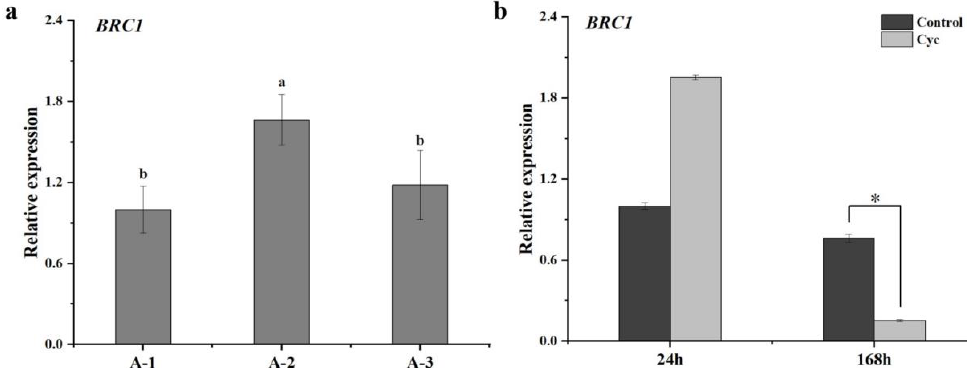
Figure 2. Overview of the BRC1 expression level using qRT-PCR. ( a ) The BRC1 expression level among the different maturity state axillary buds at 0 h with A-1, A-2, and A-3 materials ( b ) The BRC1 expression level after cyclanilide (Cyc) treatment at 24 h and 168 h with A-1 material. Significant differences analysis based on the Tukey test in ( a ) and t -test in ( b ) (* p < 0.05). Data represent the mean ± SD ( n = 3).